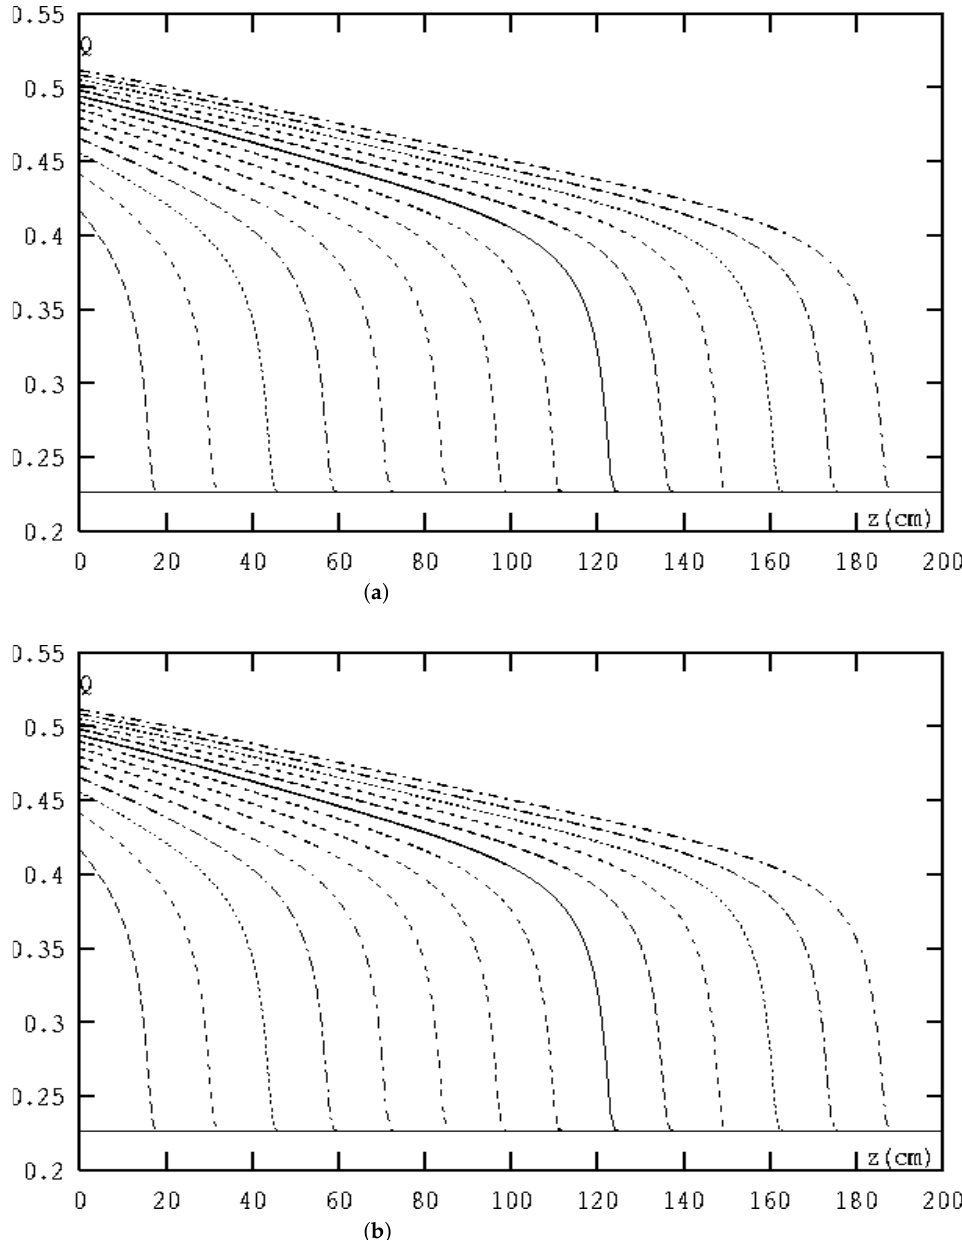
Figure 1. ( a ) The curves are the PPMFERD solutions of infiltration water content at t = 60 h, 120 h, . . . , 420 h, respectively. ( b ) The curves are the MFE solutions of infiltration water content at t = 60 h, 120 h, . . . , 420 h,